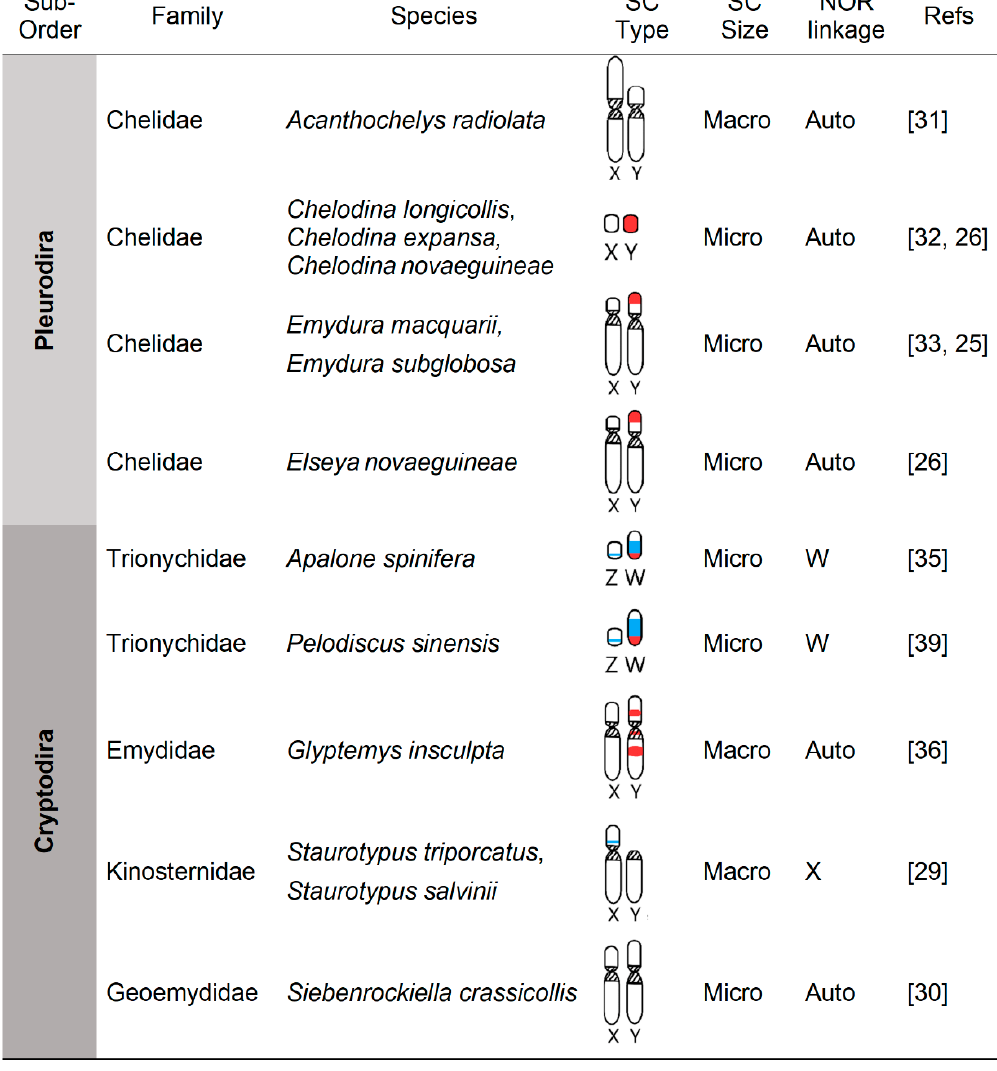
Figure 2. Karyotypic characteristics of turtle sex chromosomes (SC) from species studied cytogenetically. Macro = macro-chromosomes; Micro = micro-chromosomes; Streaked regions = centromeres; blue = nucleolar organizing region (NOR); red = male-specific regions in the Y or female-specific region in the W, detected via CGH; as described in the text and reviewed in [28] .